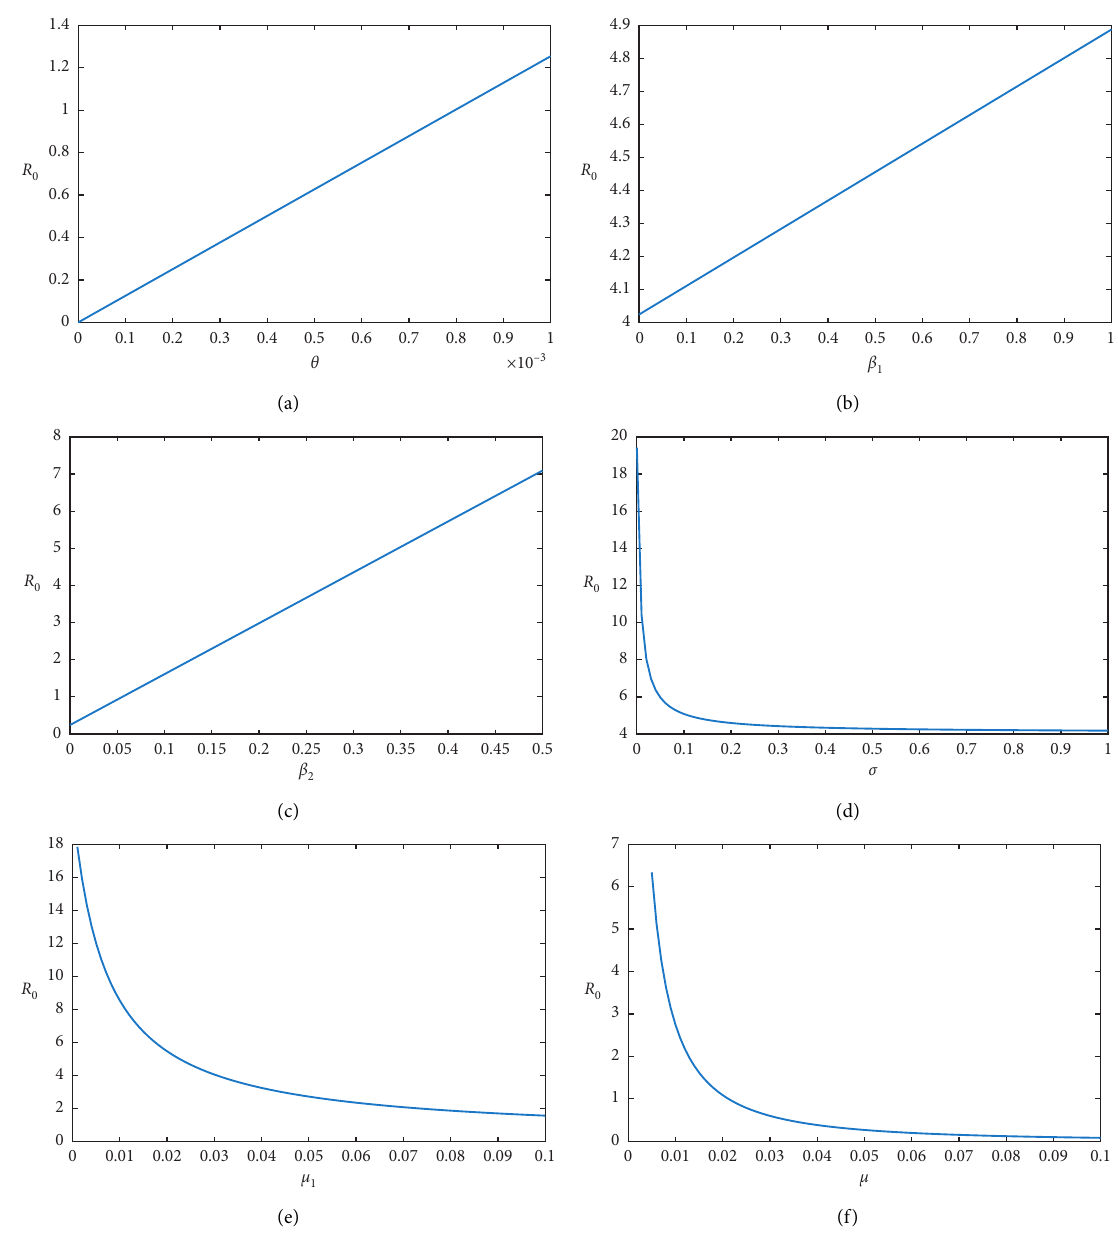
Figure 5: Effects of six parameters for R � 0 . 0 . 007 , and μ 1